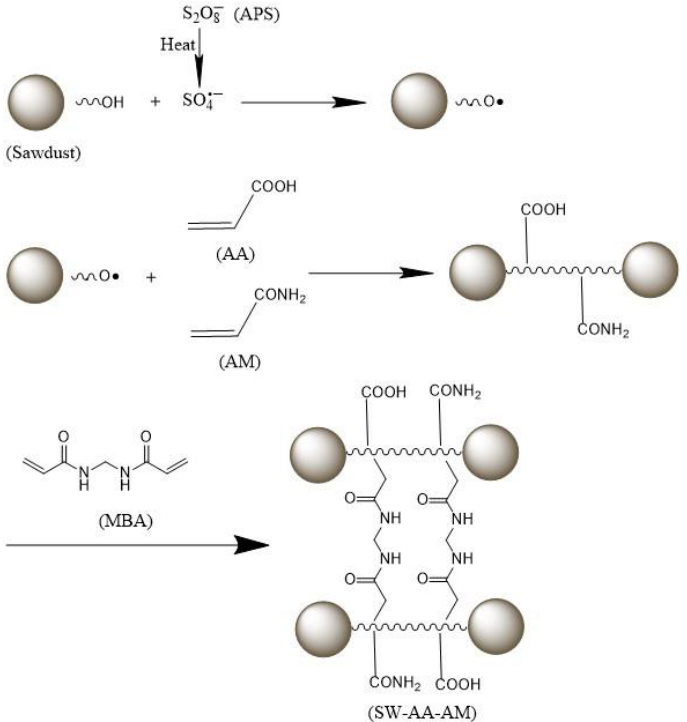
Figure 5. Mechanistic diagram of SW-AA-AM polymer formation.